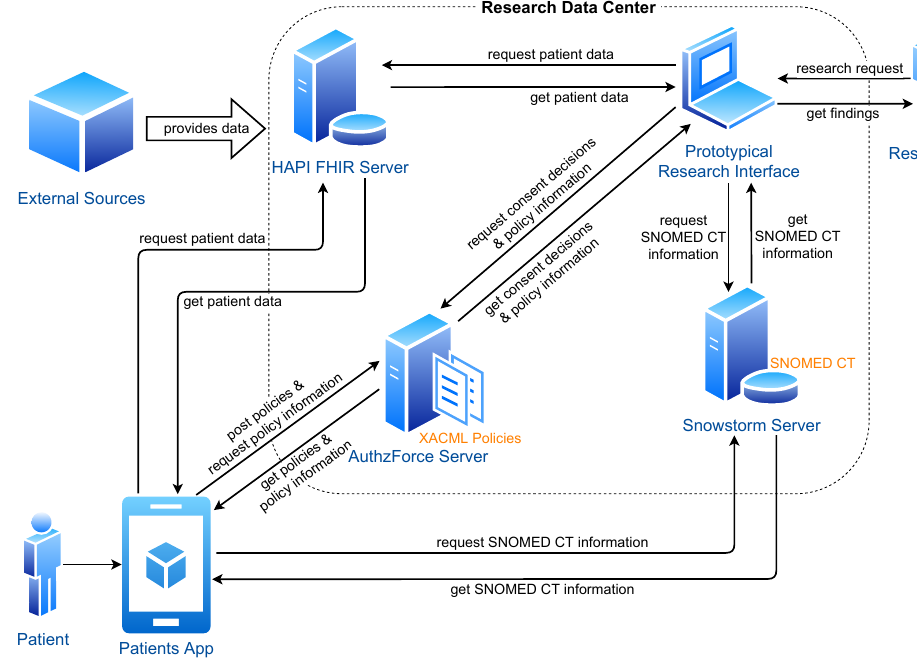
Figure 5. System architecture of the prototypical Dynamic Consent